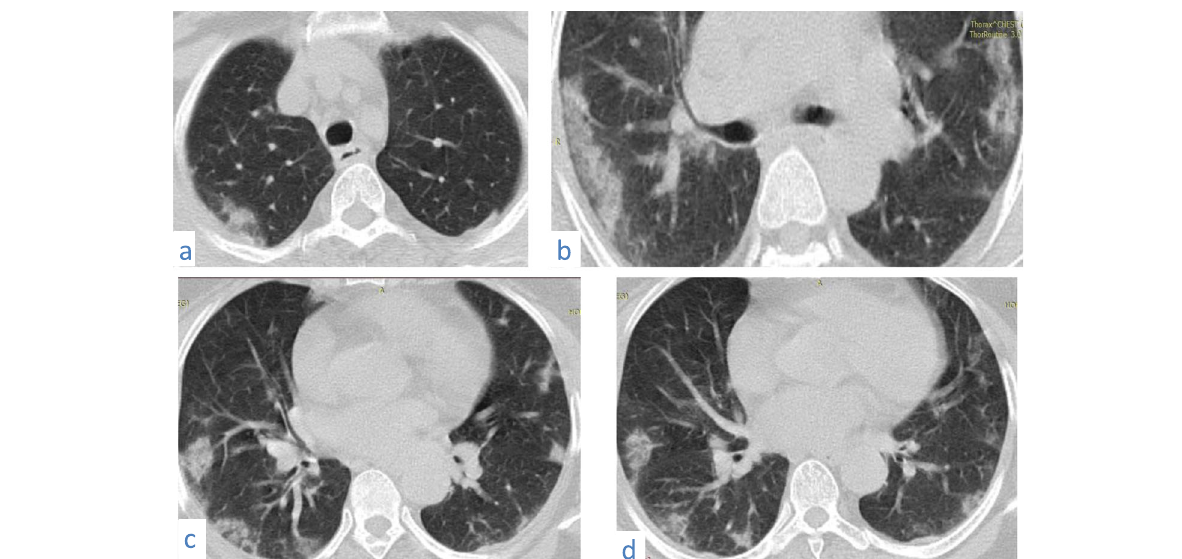
Fig. 8 A 57-year-old male patient with COVID-19, CT chest axial images ( a – d ) show bilateral predominantly subpleural consolidation with tiny lucencies within “ vacuolar sign